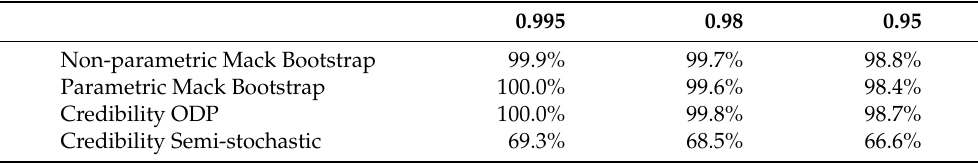
Table 4. Which actual VaR does the estimated VaR approximate if the underlying model is